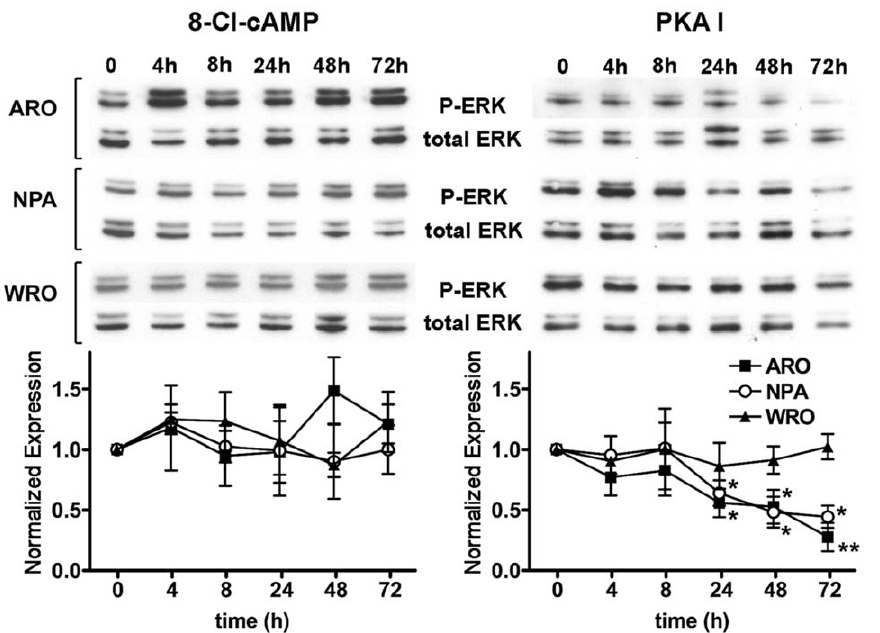
Figure 5. Effect of 8-Cl-cAMP or the PKA I-selective cAMP analogs on ERK phosphorylation. ARO, NPA and WRO cells were treated with 8- Cl-cAMP (100 m M) or the PKA I-selective cAMP analogs (100 m M each) for the indicated periods of time. The levels ERK 1/2 phosphorylated at Thr202/ Tyr204 and total ERK were measured by Western blot analysis. Shown are representative Western blots as well as the densitometric analysis of three to four independent experiments. The P-ERK/total-ERK ratios are expressed as the relative variation versus the basal levels of each single experiment. * P , 0.05 vs. basal. ** P , 0.01 vs. basal.